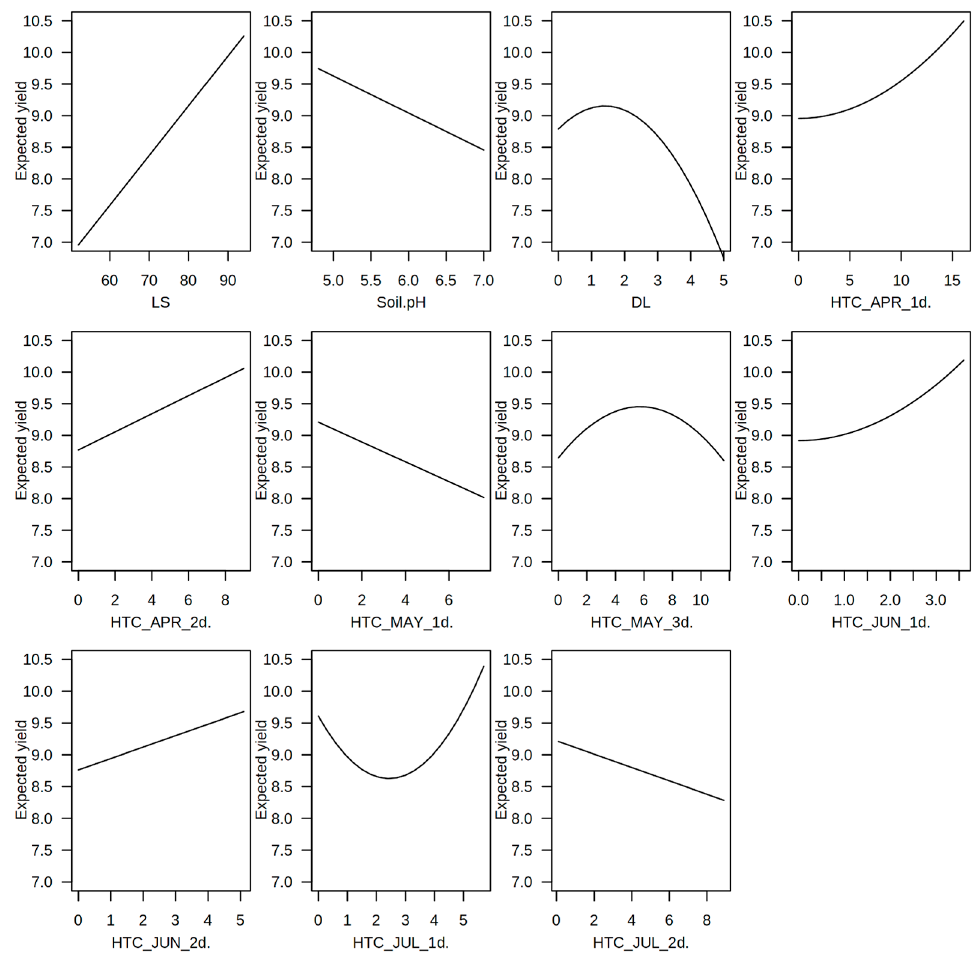
Figure 2. Mean yield (t/ha) at HIM management level depending on the quantitative explanatory variables (environmental).